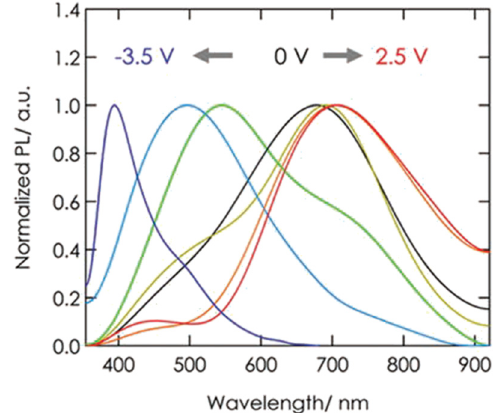
Figure 9: DC bias dependence of normalized PL spectra tuned by application of various bias voltages for 1,200 s [ 93 ]